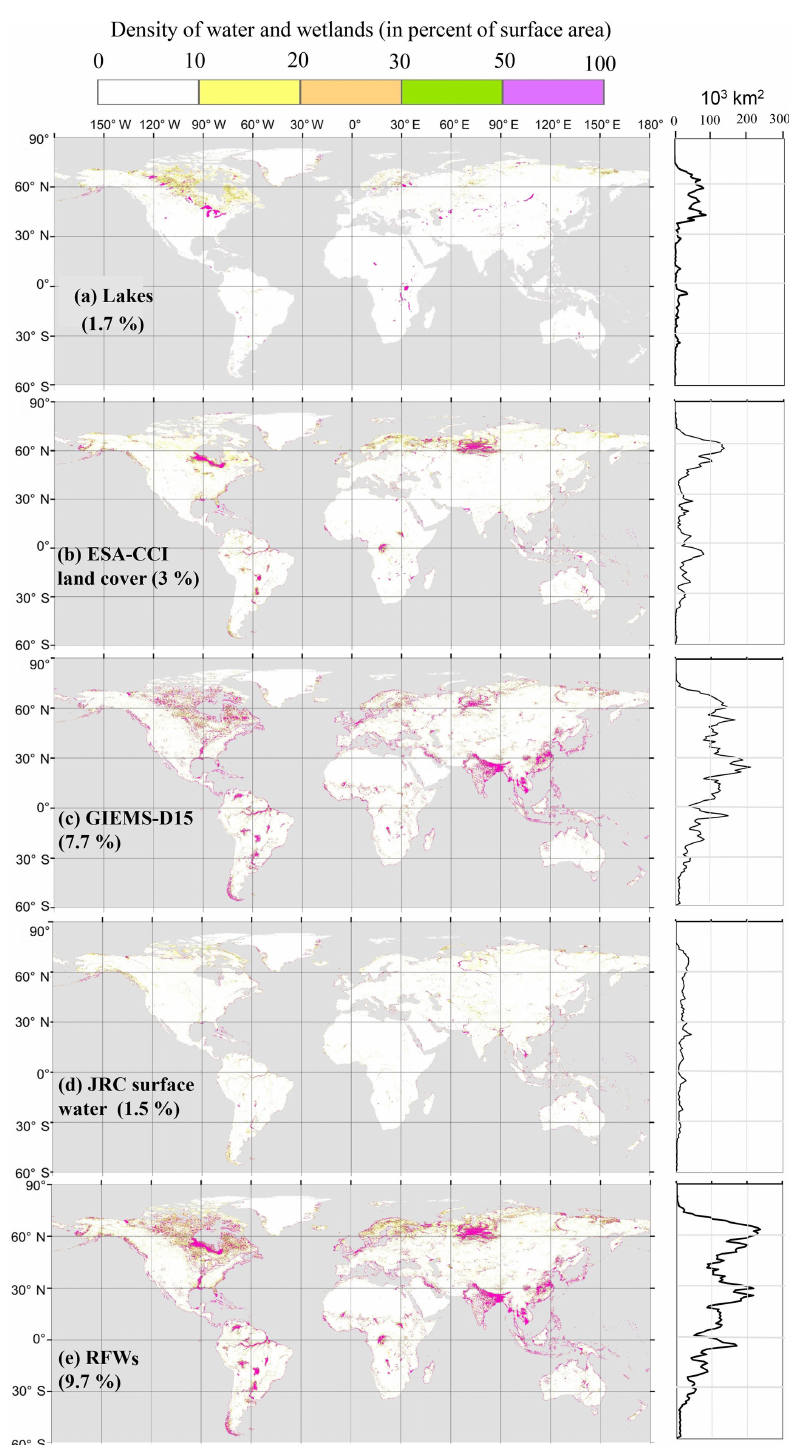
Figure 1. Density of lakes, regularly flooded wetlands and components of the latter (percent area in 3arcmin grid cells). For zonal wetland area distributions (right-hand charts), the area covered by wetlands in each 1 ◦ latitude band is displayed.